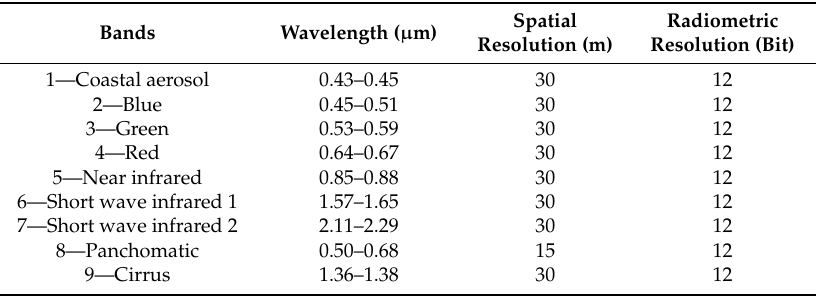
Table 1. Band information of the Landsat 8 Operational Land Imager (OLI) images.